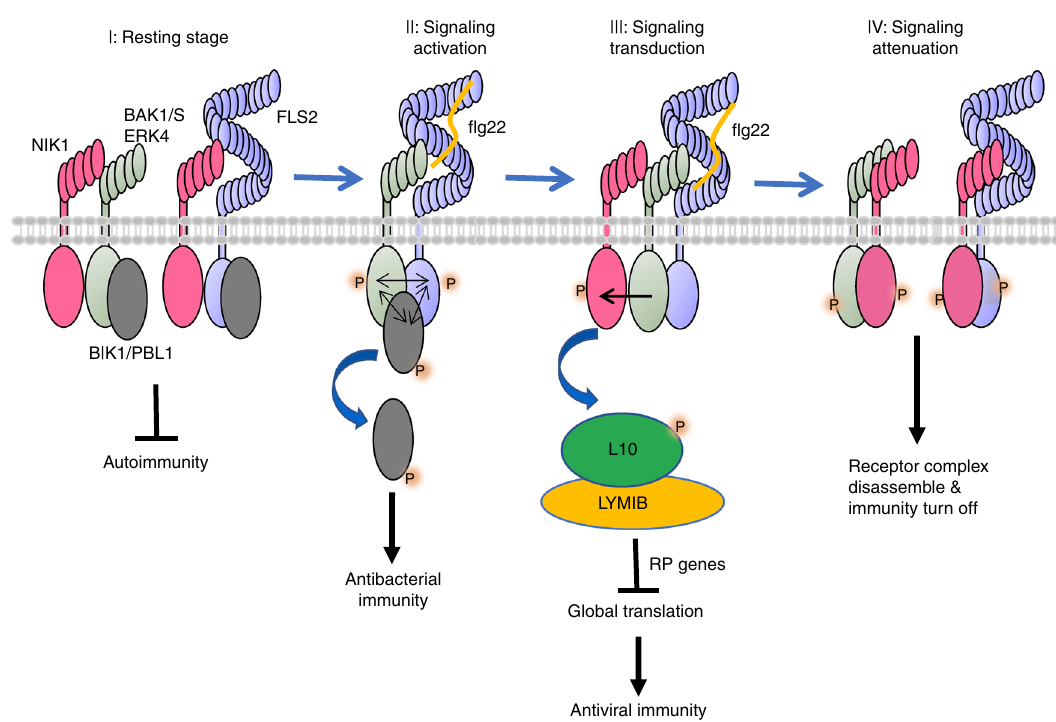
Fig. 7 Working model for NIK1 roles in FLS2 signalling pathway and fl g22-induced translational control of NIK1 signalling. (I) At the resting stage, NIK1 associates with FLS2 or BAK1 to prevent autoimmunity without pathogens invasion. (II) Upon bacterial infection, fl g22 is perceived by the immune receptor FLS2, which induces the heterodimerization with BAK1, also including RLCK BIK1 and its homologues. Phosphorylation events initiates the immune signalling, and BIK1 is released from the membrane to activate downstream signal. (III) During signalling transduction, BAK1 may phosphorylate NIK1 on Thr474 residues. Phosphorylated NIK1 leads to activation of an antiviral signal through RPL10 phosphorylation and suppression of translational machinery- related gene expression. (IV) At signalling attenuation stage, phosphorylated NIK1 exhibits higher af fi nity to FLS2 and BAK1, and these interactions may lead to receptor complex instability or disassembly, followed by FLS2 ubiquitination and